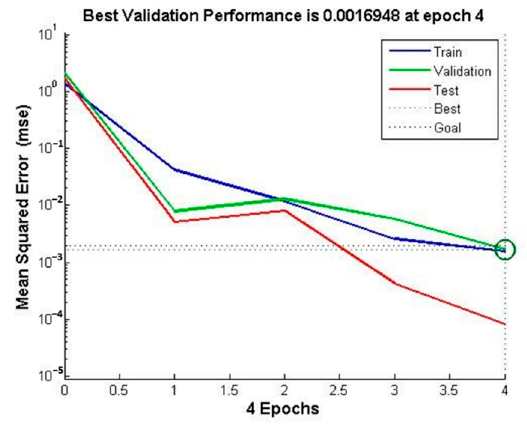
Figure 18. Iterations of calculation.